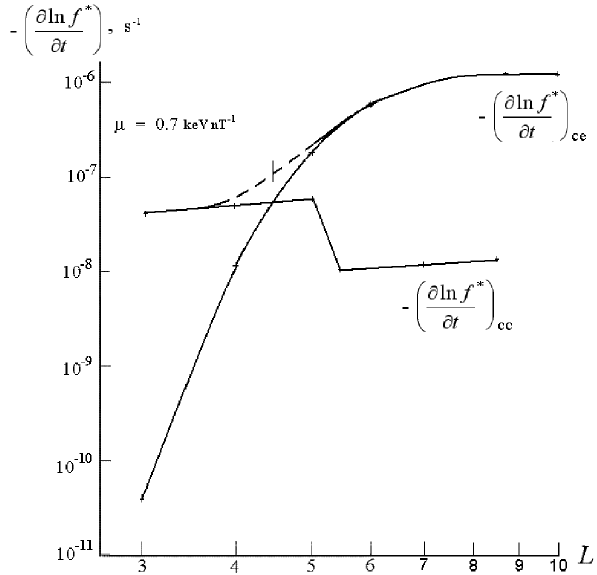
Figure 7. The example of summation of the rates of the Coulomb losses, − (cid:0) ∂ ln f ∗ /∂t (cid:1) , and losses on charge exchange, cc